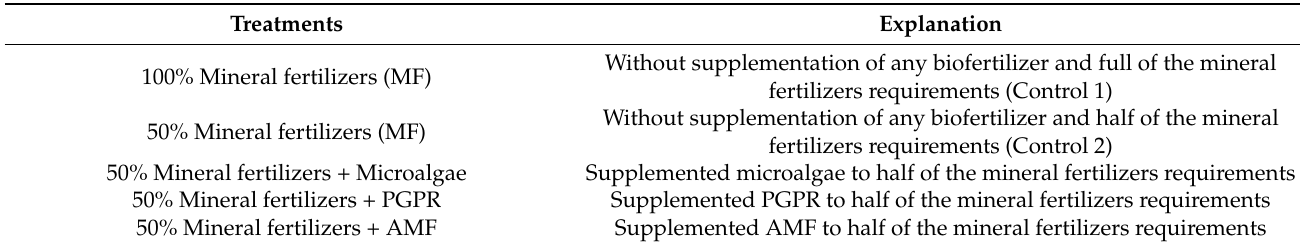
Table 3. Treatments of mineral and biofertilizer applications of the